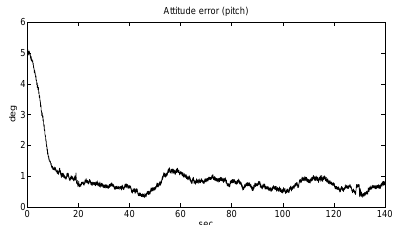
Figure 7: Convergence of the pitch